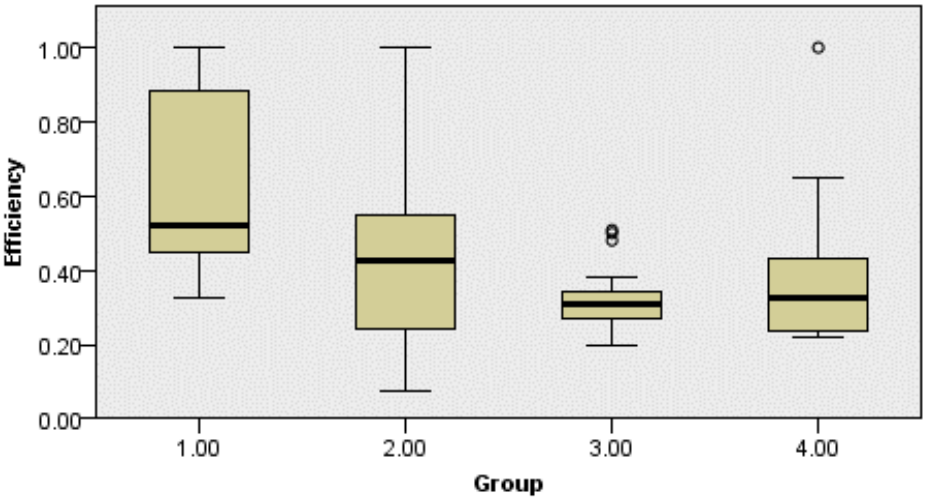
6 of 14 Table 5. Pairwise comparison results. Comparison